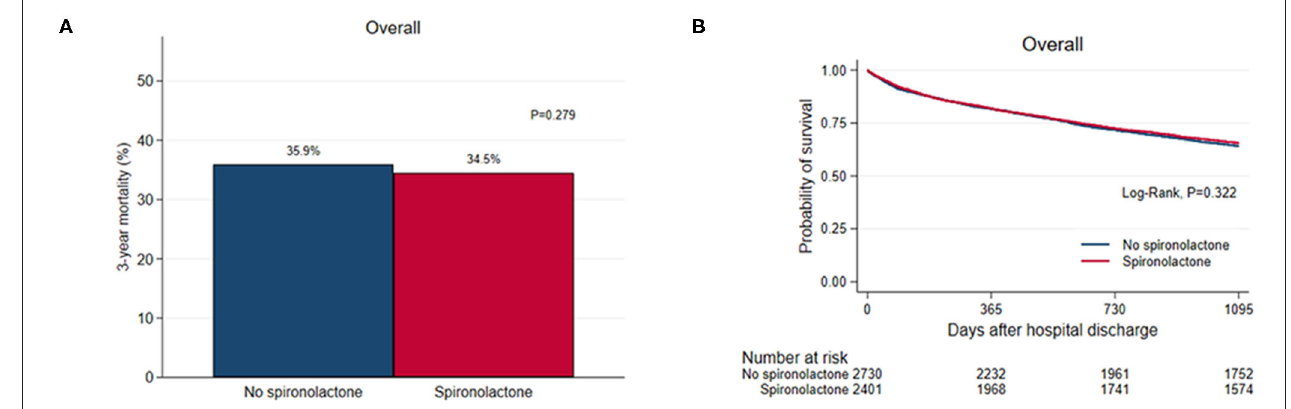
FIGURE 1 | (A) Bar graph and (B) Kaplan–Meier curves of the 3-year all-cause mortality after hospital discharge according to spironolactone treatment in overall patients.